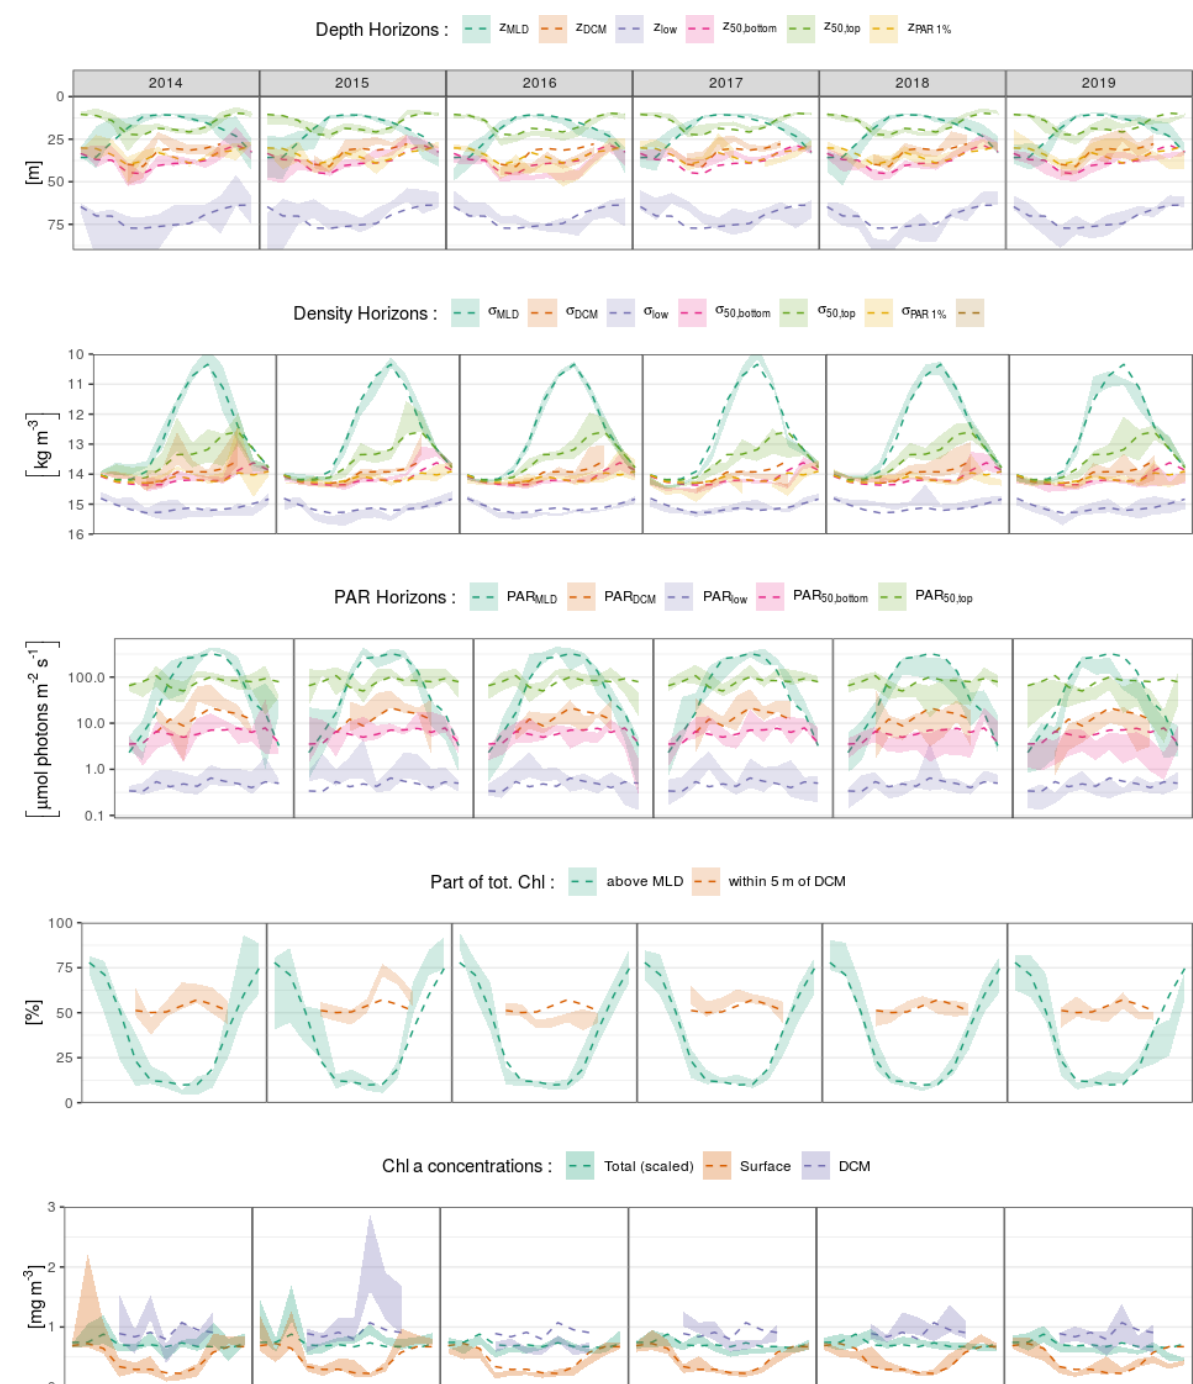
Figure C1. Interannual variability (year-specific monthly medians and confidence interval; shaded area) depicted with year-averaged monthly medians (dotted lines) for the variables presented in Figs. 5a, b, c and 6a,